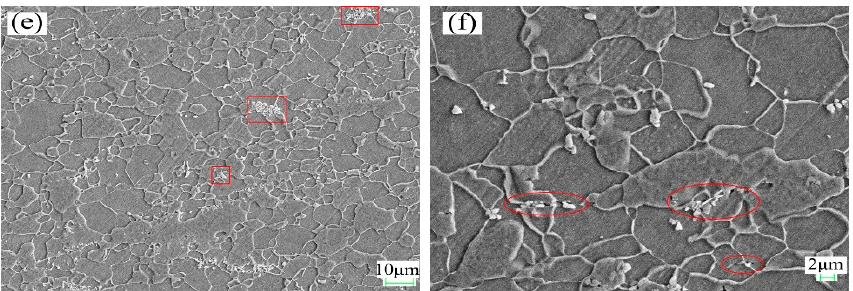
Figure 1. SEM images with different secondary cold reduction rates: ( a ) 15%, 2000×; ( b ) 15%, 5000×; ( c ) 20%, 2000×; ( d ) 20%, 5000×; ( e ) 25%, 2000×; ( f ) 25%, 5000×.